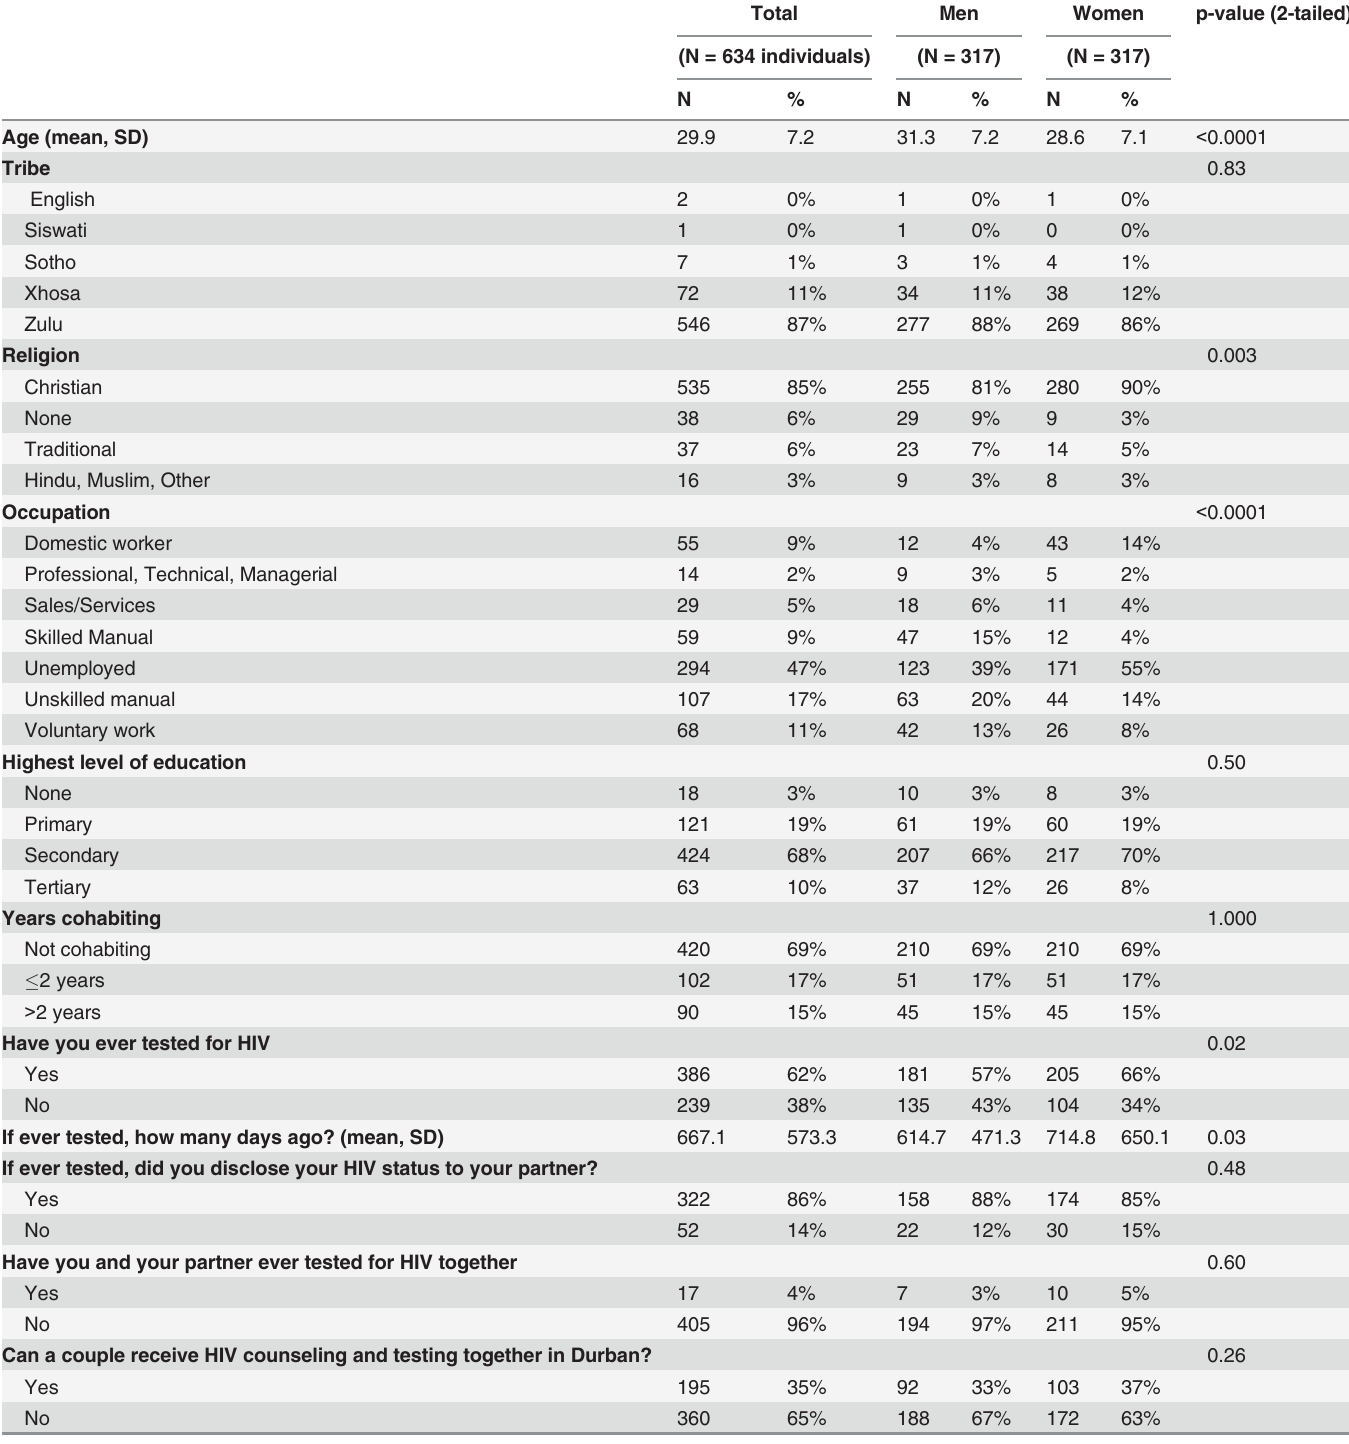
Table 1. Demographics of clients participating in CVCT and completing pre- and post-CVCT surveys stratified by gender, Durban, South Africa,